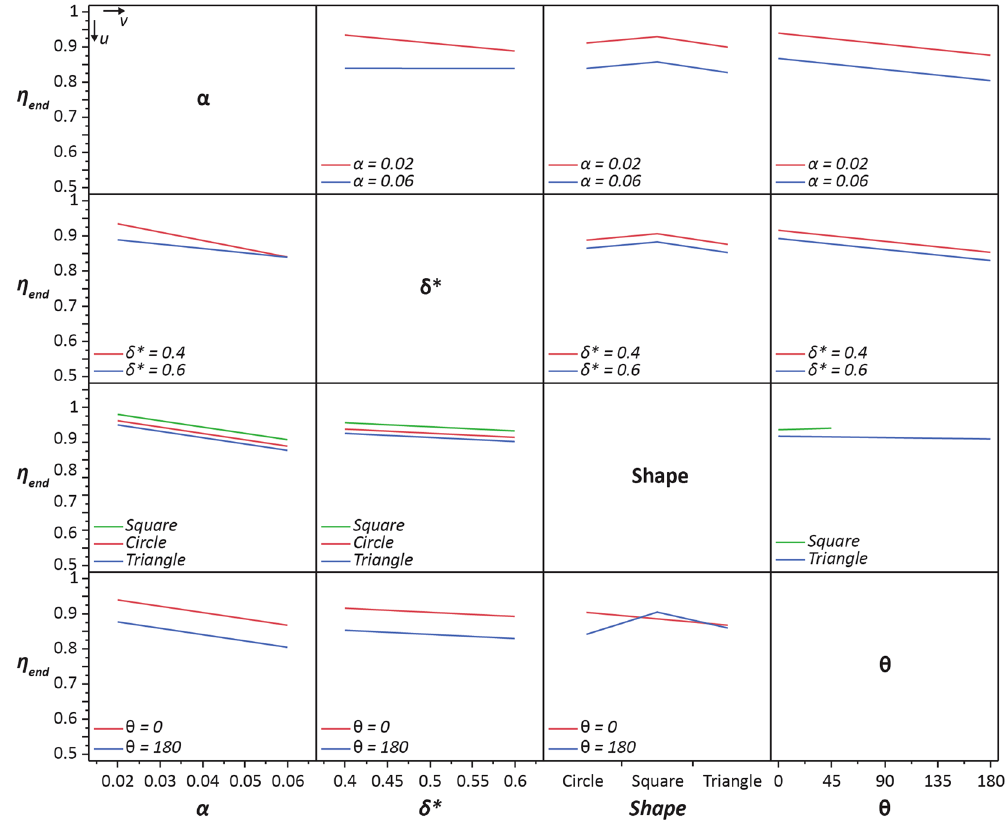
Figure 3. Interaction plot obtained by DOE data analysis of all SDSM configurations listed in Table 1. Here, JMP ® statistical software was used to show interactions between the four island parameters ( α , δ * , shape, or θ ) and their effects on the mixing efficiency ( η end ) at the end of C Wedge at t = 1 s. The plot consists of 12 sub-plots (indexed by u and v ) that show how the mixing efficiency varies with the v th island parameter for fixed values of the u th island parameter. For example, the sub-plot (1,2; i.e . u = 1, v = 2) shows how η end varies as a function of the constriction ratio ( δ * ) for two area ratios of α = 0.02 – red, or 0.06 – blue. Similarly, the sub-plot (3,4) shows how η end varies with island orientation ( θ ) for fixed island shapes (square – green, triangle – blue). A detailed explanation of how these plots were generated can be found in section S4 of the